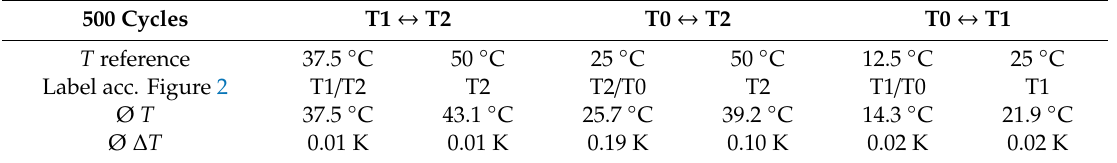
Table 4. Preliminary thermal cycling test of inhomogeneous transient setups (IT) measured at the central position between each pair of cell holder plates during steady-state sections.